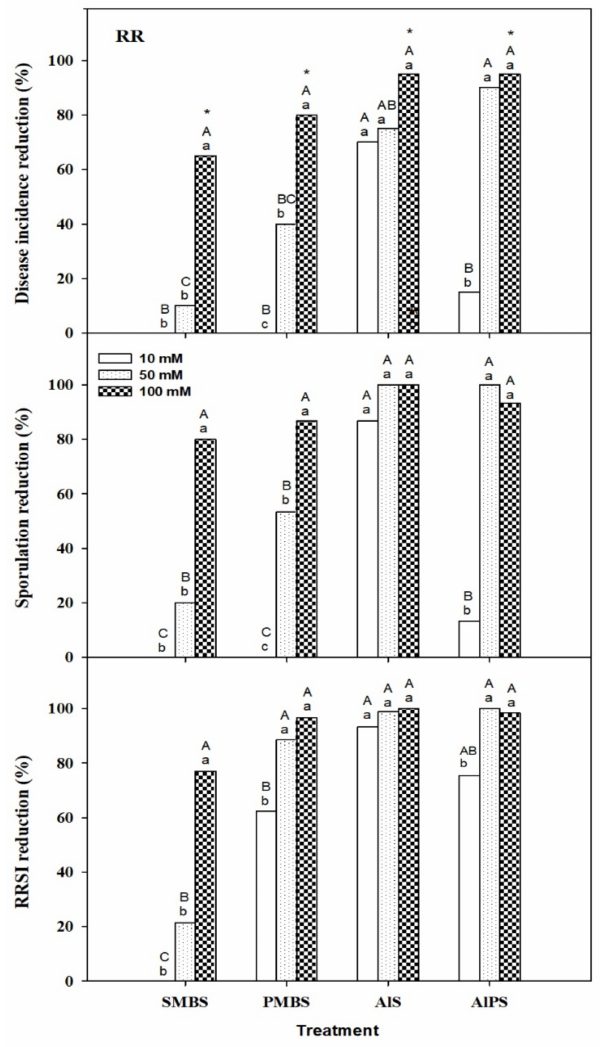
Figure 2. Curative activity of sodium metabisulfite (SMBS), potassium metabisulfite (PMBS), alu- minum sulfate (AlS), and aluminum potassium sulfate (AlPS) at different concentrations (10, 50, and 100 mM) against Rhizopus rot (RR) in in vivo primary screenings with ‘Luciflora’ nectarines artificially inoculated with Rhizopus stolonifer , treated 2–3 h later, and incubated for 4 days at 20 ◦ C. Reductions in disease incidence, pathogen sporulation, and Rhizopus rot severity index (RRSI, score 0–4) were determined with respect to control fruit treated with water, in which incidence, sporu- lation, and RRSI were respectively 100%, 100%, and 3.1. For each dependent variable, columns with different capital letters indicate significant differences among salts for each concentration and different lowercase letters indicate significant differences among concentrations for each salt (Fisher’s protected LSD test, p < 0.05, after an ANOVA). Incidence and sporulation were arcsine-transformed. Non-transformed means are shown. * indicates treatments that caused visible peel